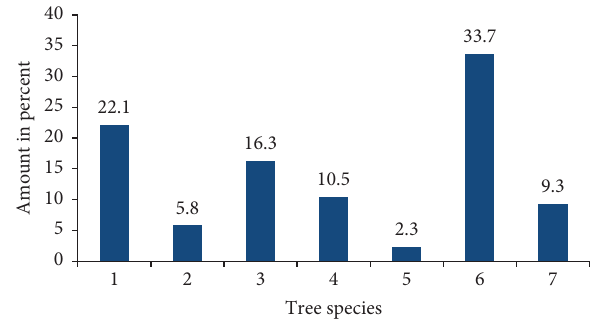
Figure 2: Preferred tree species for charcoal production at Ofa Woreda. (tree species: 1 � Combretum molle , 2 � Cuspidate cif , 3 � Terminalia schimperiana , 4 � Syzygium guineense , 5 � Olea capensis , 6 � Acacia tortilis , 7 � Acacia seyal ). source: feld survey result